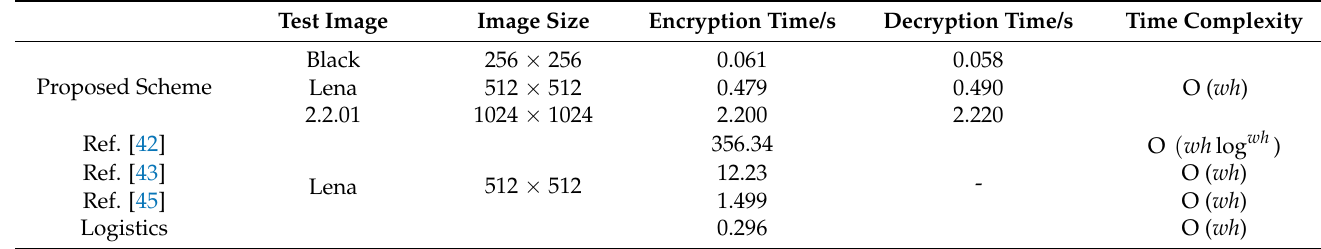
Table 2. Time of Table 2. Time of encrypting/decrypting.